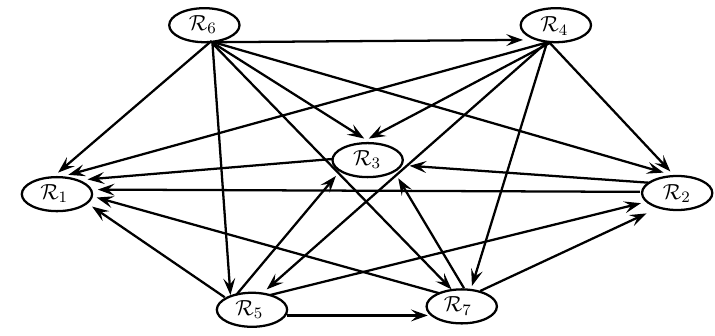
Figure 6: Partial relations of PROMETHEE I Figure 6. Partial relations of PROMETHEE I.